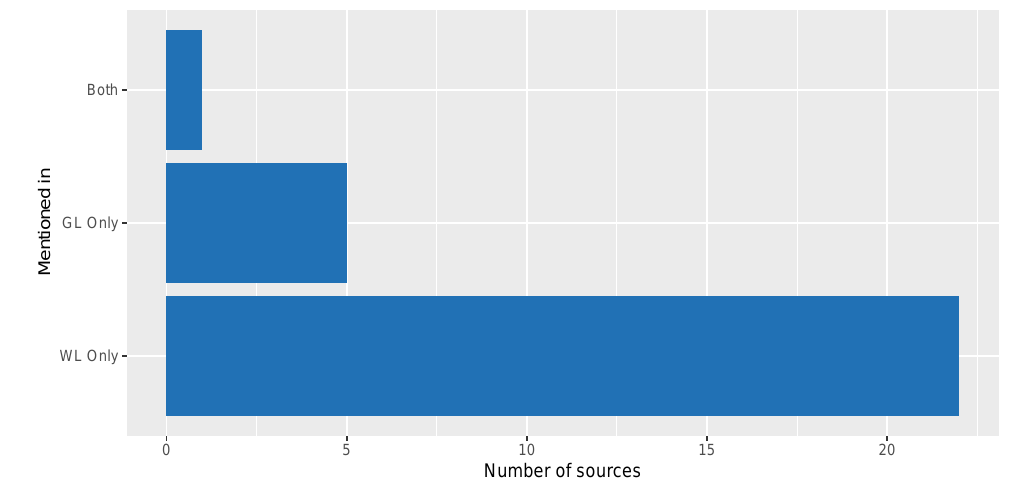
Figure 15. Exclusive and common datasets for typology of